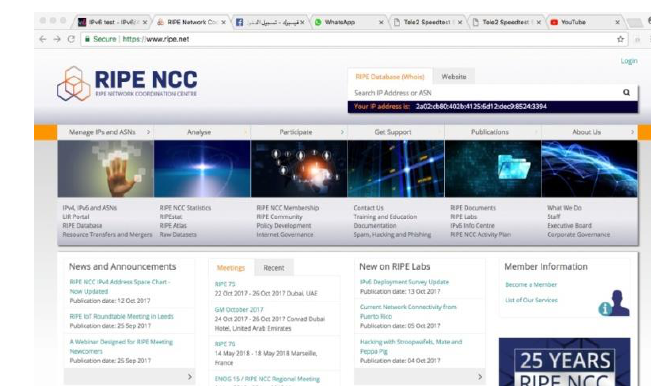
Fig. 13. Dual stack source address selection trace